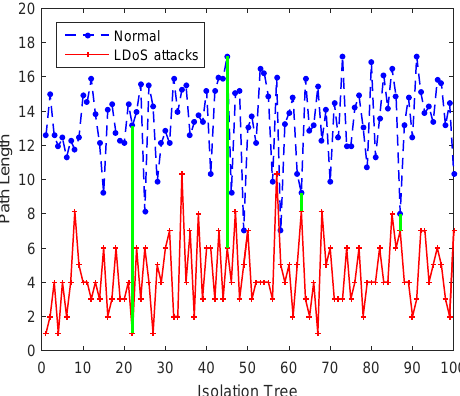
Figure 8. Path length of two kinds samples in the isolation